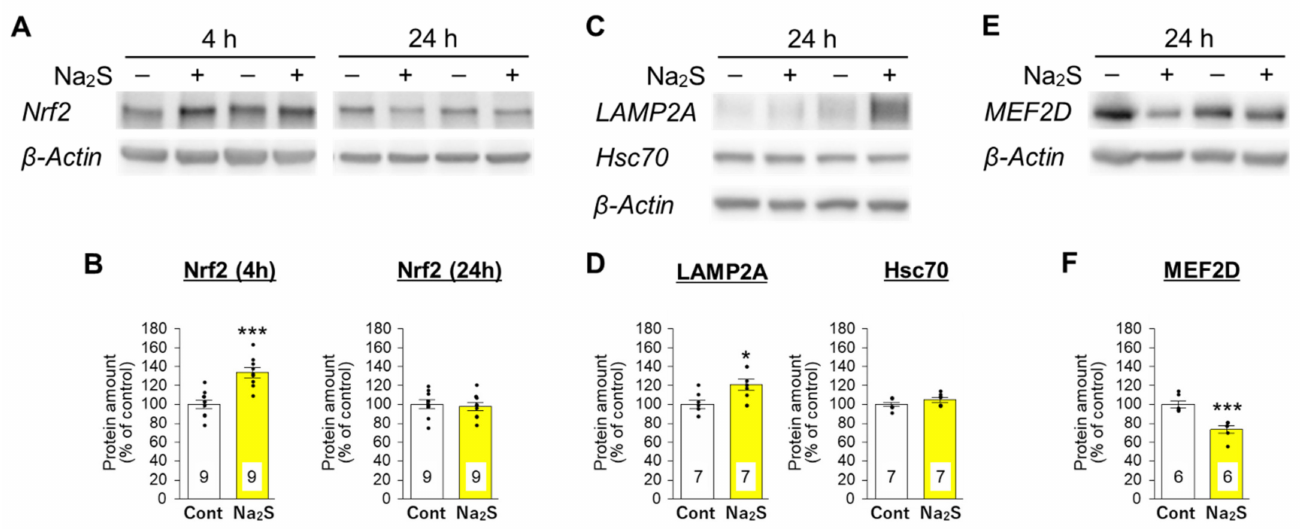
Figure 7. Effect of Na 2 S on the amounts of Nrf2 and CMA-related proteins in AD293 cells. ( A ) Im- munoblot analyses of Nrf2 and β -actin in cell lysates from AD293 cells treated with Na 2 S (10 µ M) for 4 and 24 h. ( B ) Quantitative analyses of Nrf2 amounts from the immunoblot results shown in A. ( C ) Immunoblot analyses of CMA-related proteins (LAMP2A, Hsc70) and β -actin in cell